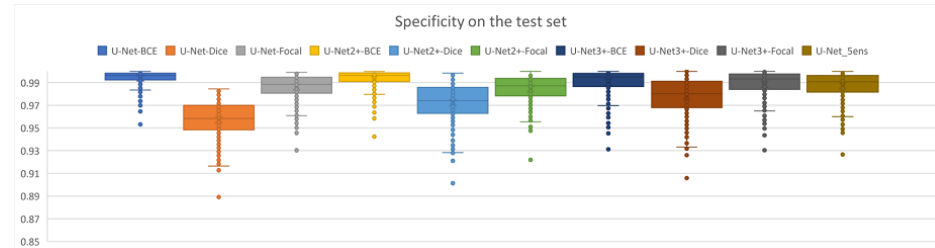
Figure 20. Boxplot comparison of the 9 networks and ensemble on images of the test set.